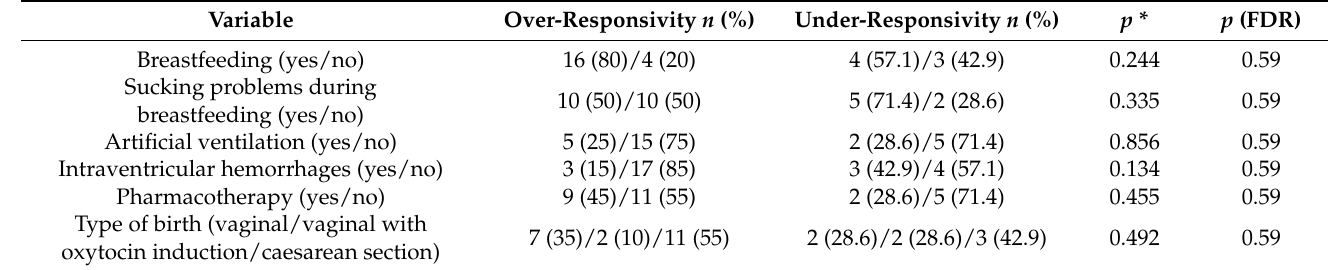
Table 2. TSM disorders by means of neonatal period complications.